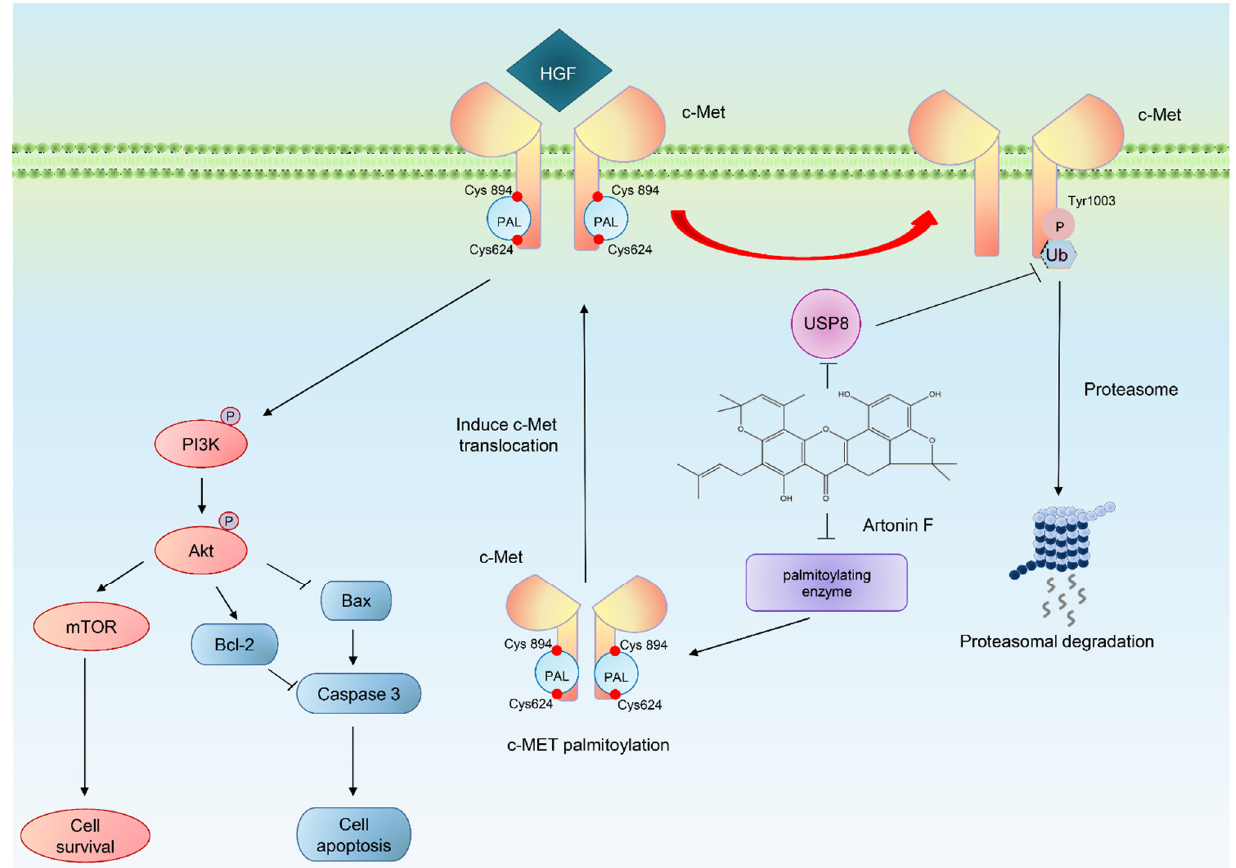
Figure 9. Schematic diagram of artonin F, which has a potential ability to induce apoptosis in human lung cancer cells and specifically triggers the ubiquitin-proteasome degradation of c-Met by inhibiting the activity of USP8 and at the catalytic residues of palmitoylating enzymes, this compound acts as a competitive inhibitor. The mechanism of action of artonin F is relatively specific through PI3K/Akt/mTOR signaling pathway.